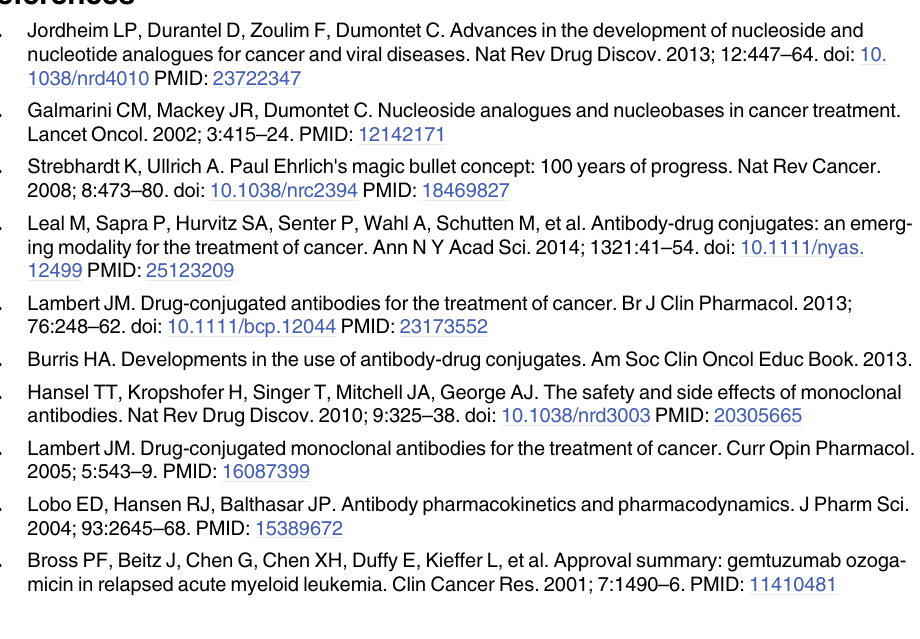
S2 Fig. Her2 expression in cancer cell lines.